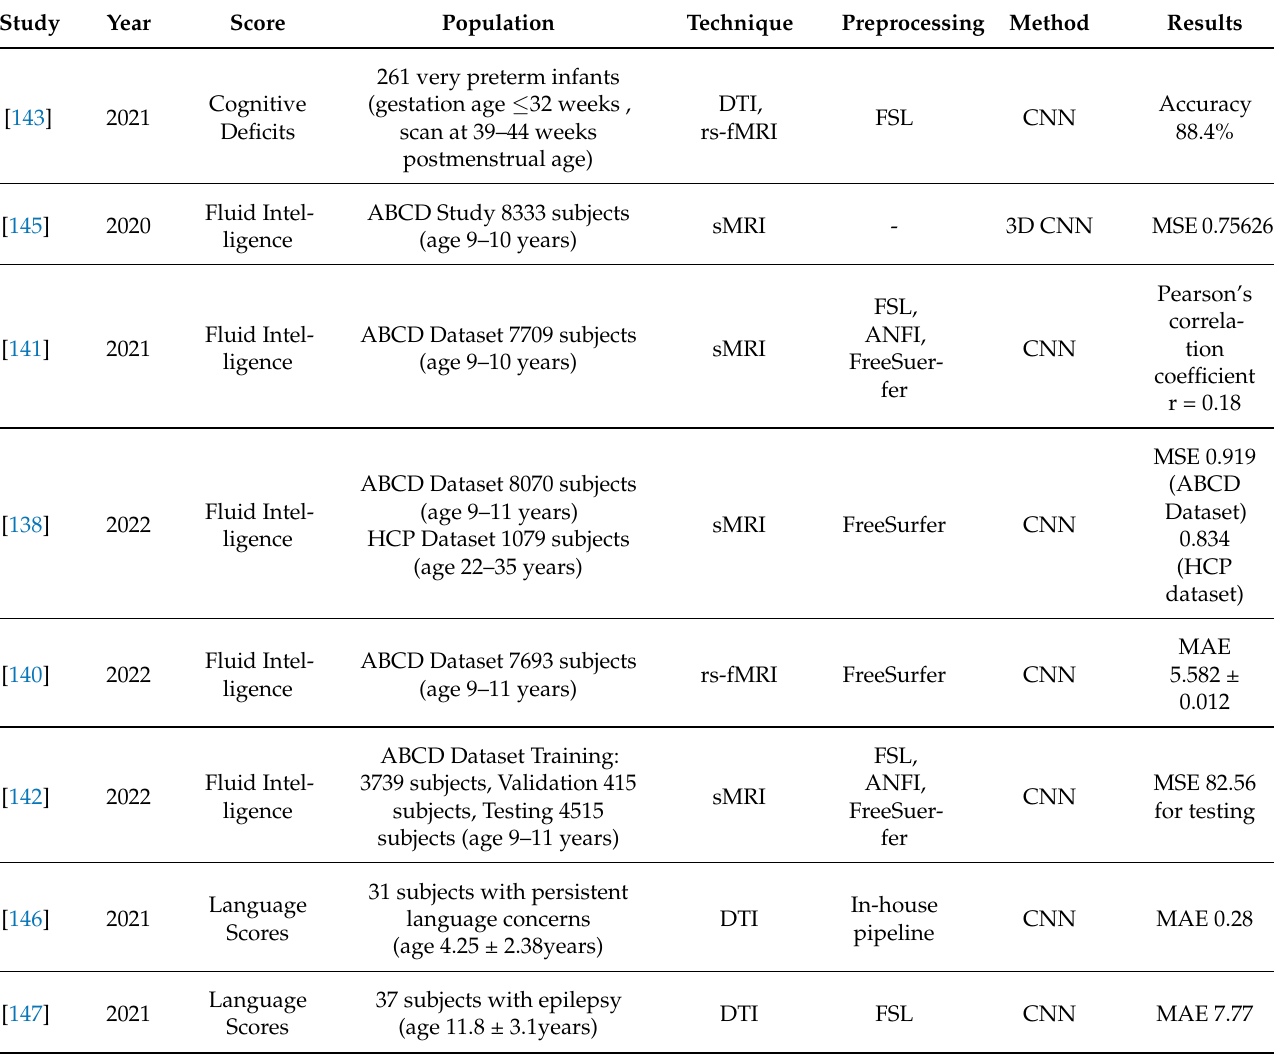
Table 5. Predicting neurodevelopment